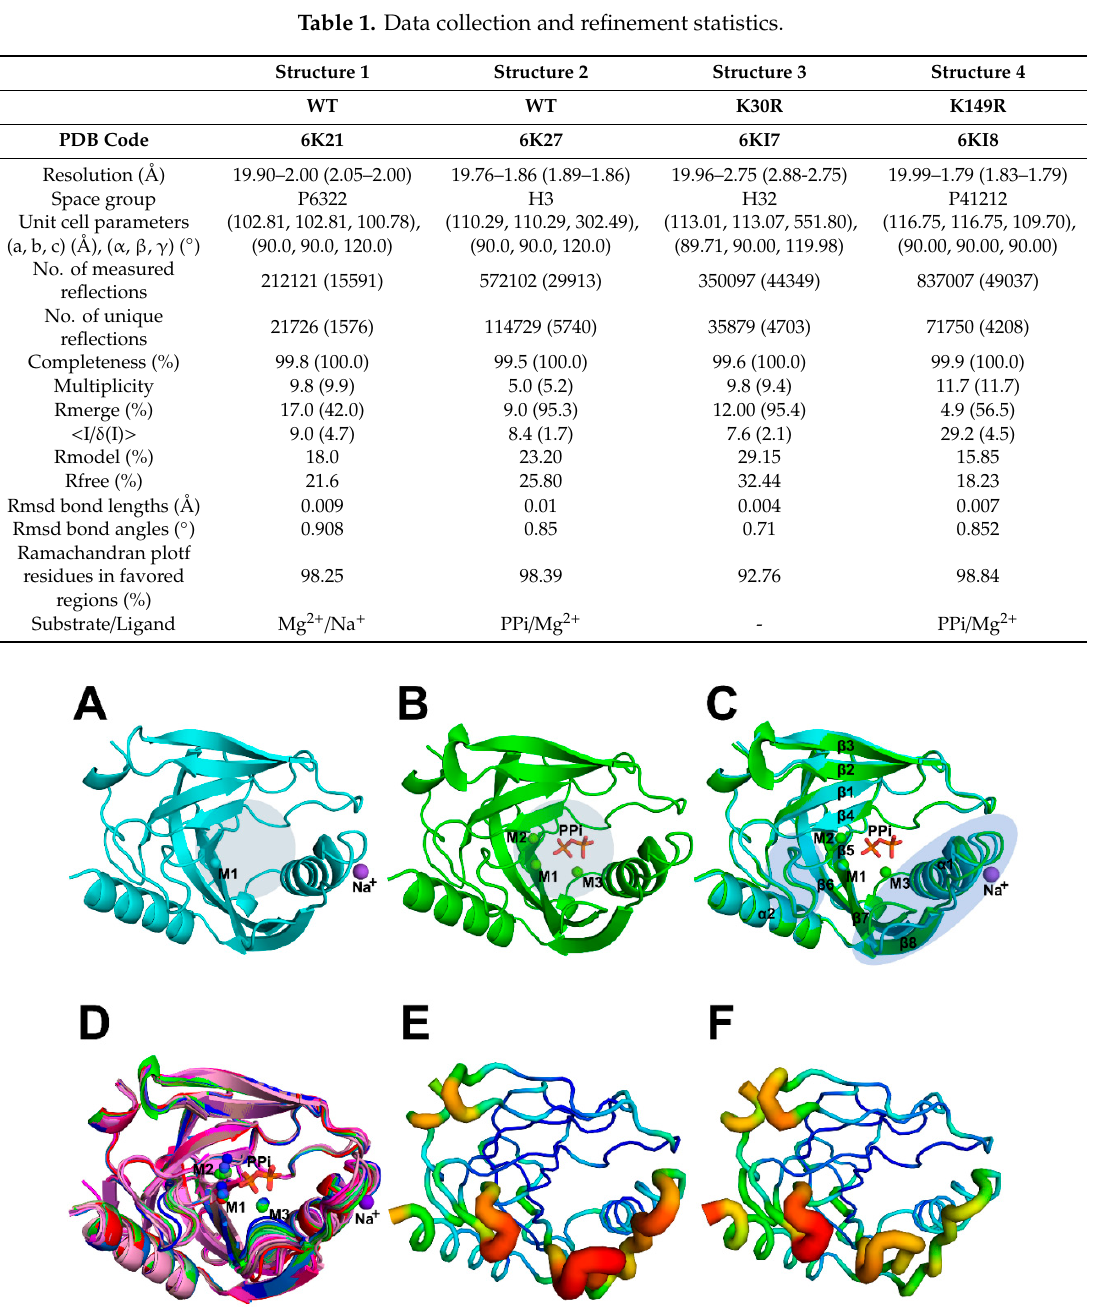
Figure 1. Crystal structures and B-factors analysis of WT AbPPase. ( A ) Structure 1 of AbPPase without PPi. One Mg 2+ (M1) bound to the catalytic center, and one Na + is bound to a loop close to the catalytic center. Round light gray shades represent the catalytic center position. ( B ) Structure 2 of AbPPase with three Mg 2+ ions (M1, M2, and M3) and one PPi bound at the catalytic center. Round light gray shades represent the catalytic center position. ( C ) Alignment of the Structures 1 and 2 of AbPPase. These structures are similar to each other. However, two regions close to the catalytic center could not be perfectly merged, i.e., region 1 located between β 4 and β 5 and region 2 located between α 1 and β 8. Elliptical light purple shades represent the positions of both loops. ( D ) Alignment all of the monomers from Structures 1, 2, 3, and 4. The monomer from Structure 1 of AbPPase with Mg 2+ is